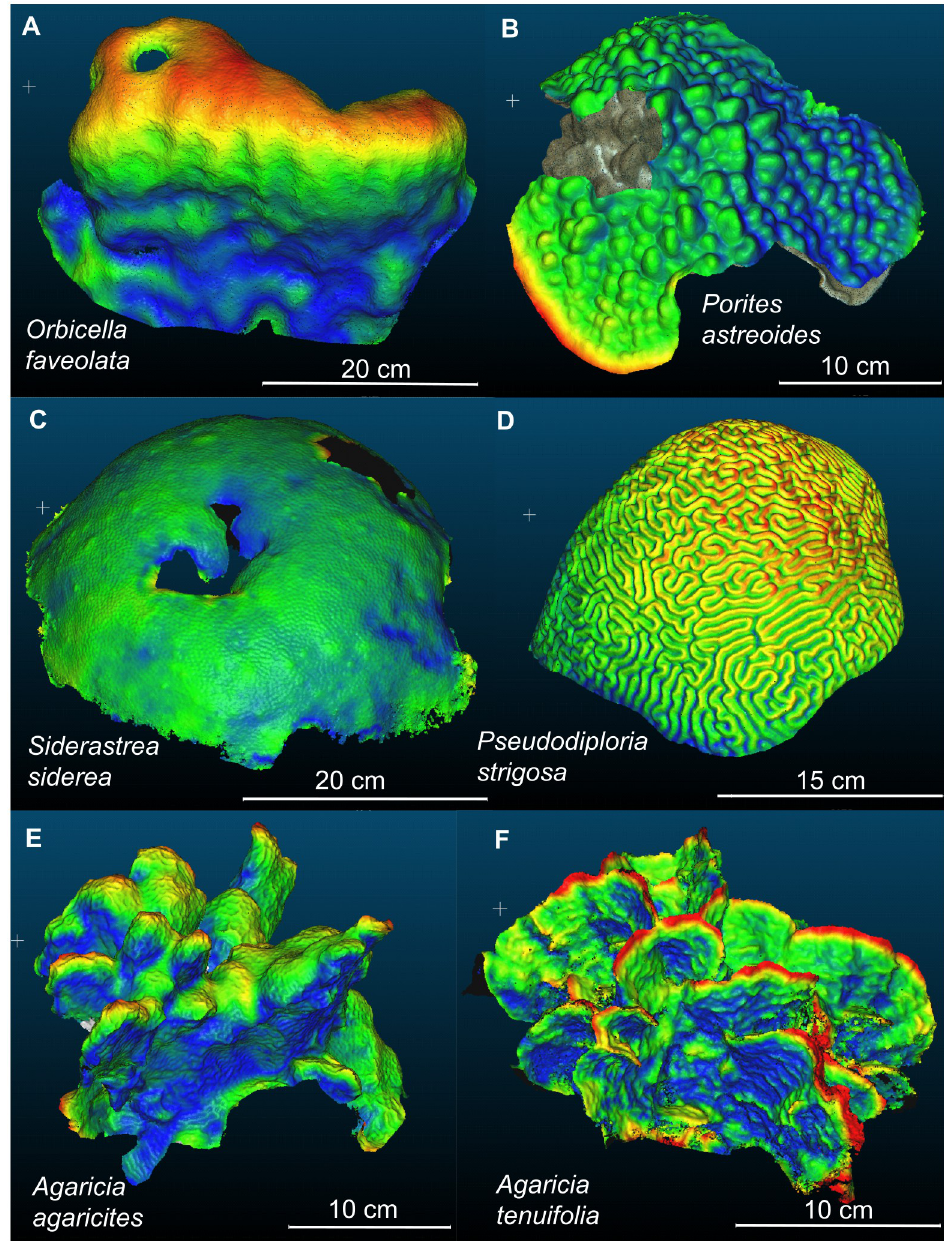
Fig 2. Colony-scale growth of six Caribbean coral species. The same coral colonies were photographed in subsequent years and colours display the distance between dense point clouds (red > yellow > green > blue) overlaid in the software CloudCompare. Note that highest growth often occurs on upper colony surfaces (A, C, D), around edges (B) or on bumps, columns and frond edges (B, E, F). A) The cavity in the top left area indicates the position of a core taken in 2021 for analysis with CT scans. B) Partial mortality between surveys shows the prior colony model below the more recent one.